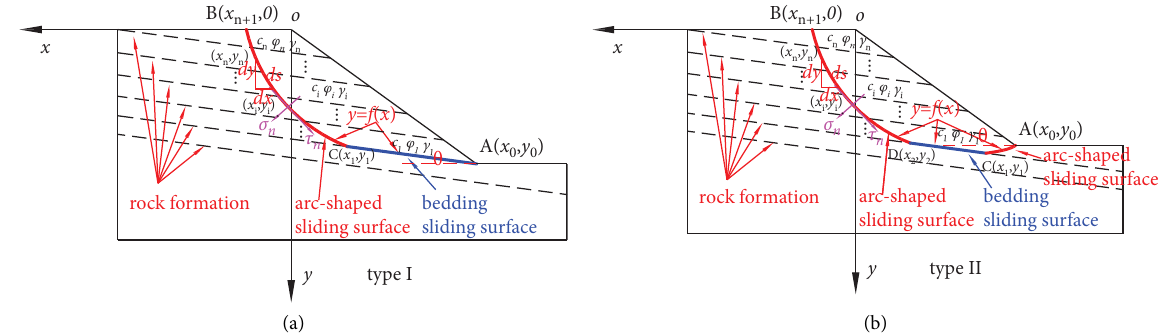
Figure 11: Sectional calculation diagram of stability coefcient of sandwich slope: (a) bedding sliding type I and (b) bedding sliding type II.